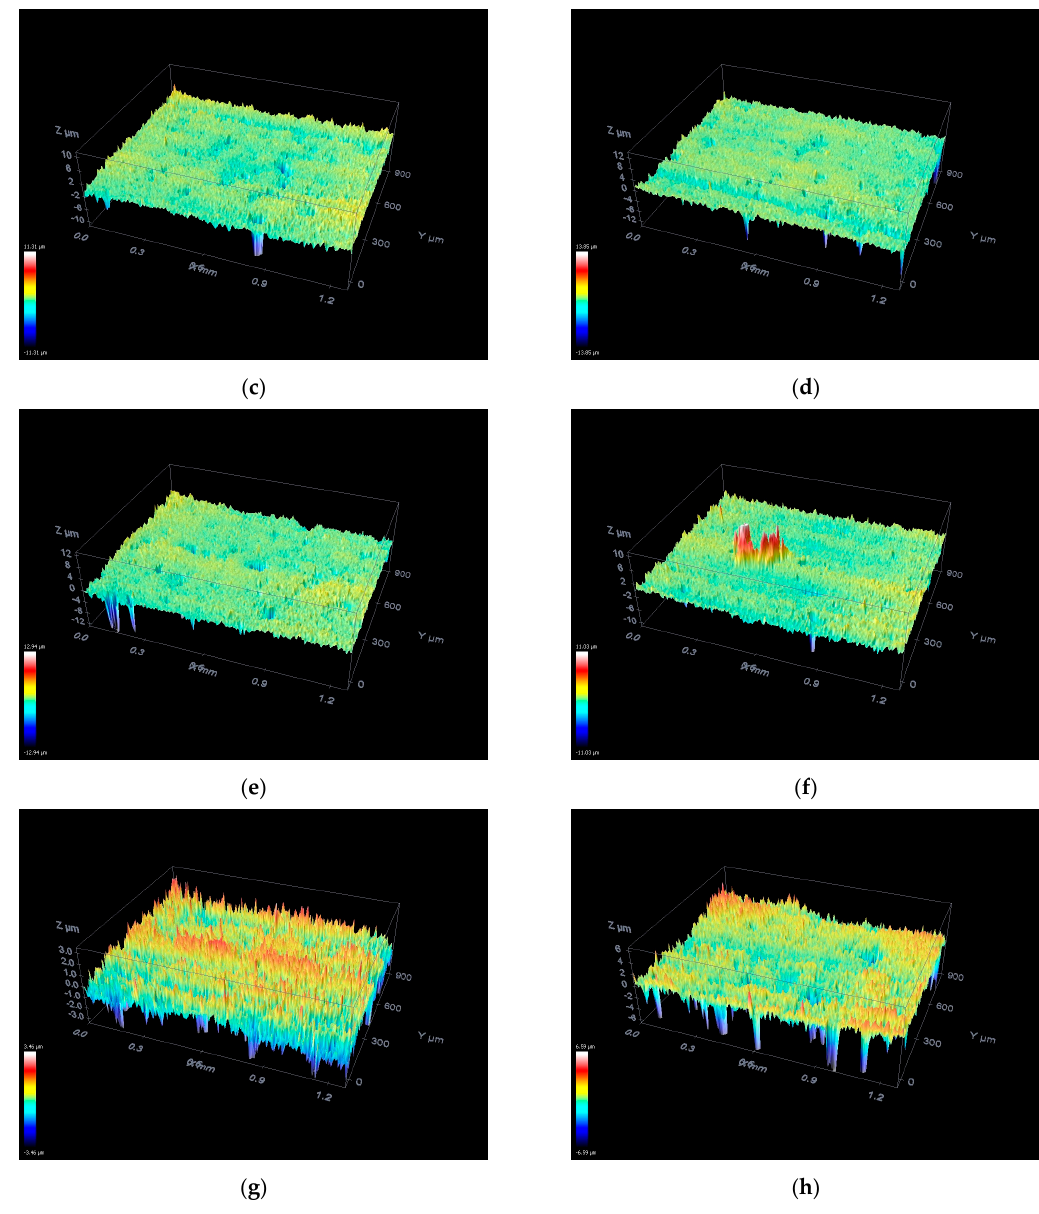
Figure 3. Confocal microscopy: ( a ) Without cutting; ( b ) 25 µm; ( c ) 35 µm; ( d ) 50 µm; ( e ) 105 µm; ( f ) 150 µm; ( g ) 210 µm; and ( h ) 350 µm. Table 2. Mean surface roughness (Ra) measured with a portable roughness